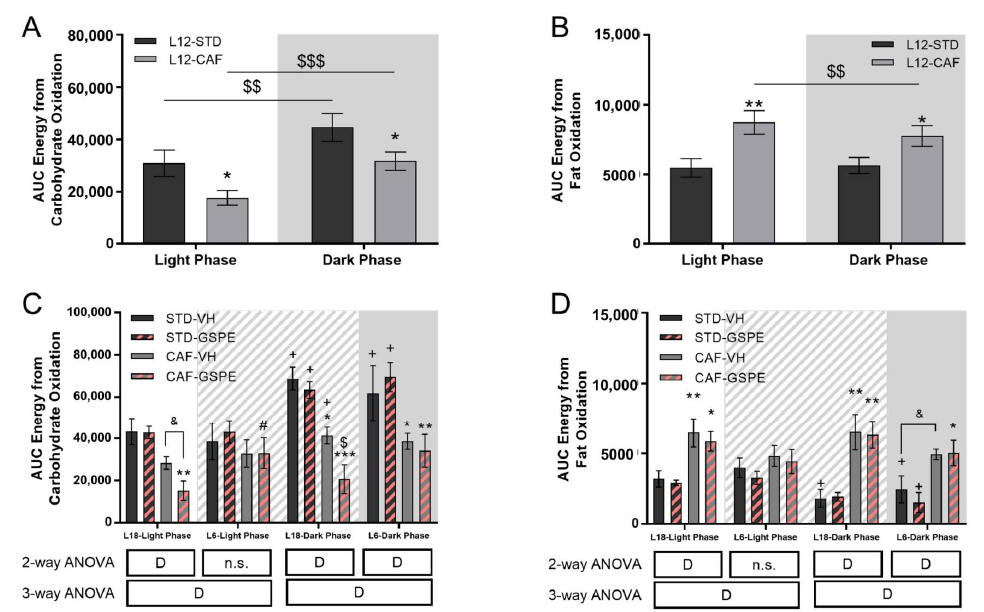
Figure 4. Energy from carbohydrate or fat oxidation of STD- and CAF-fed rats in the sixth week of the experiment under L12 conditions and in the seventh week of the experiment under L18 and L6 conditions. ( A ) AUC of energy from carbohydrate oxidation for STD- and CAF-fed rats under the L12 photoperiod. ( B ) AUC of energy from fat oxidation for STD-fed rats and VH or GSPE administration under the L18 photoperiod. ( C ) AUC of energy from carbohydrate oxidation for L6 and L18 conditions groups. ( D ) AUC of energy from fat oxidation for L6 and L18 conditions groups. For L12 conditions, values are expressed as the mean ± S.E.M. ( n = 24). ¥ or ¥¥ Indicate significant differences using an unpaired Student’s t -test between L12-STD vs. L12-CAF ( p ≤ 0.05 and p ≤ 0.01, respectively). Values are expressed as the mean ± S.E.M. ( n = 6). D, diet effect; n.s., no significant differences. *, ** or *** Indicate significant differences by diet effect ( p ≤ 0.05, p ≤ 0.01 and p ≤ 0.001, respectively), $, $$ or $$$ Indicate significant differences by treatment effect ( p ≤ 0.05, p ≤ 0.01 and p ≤ 0.001, respectively), # Indicates significant differences by photoperiod effect using 2-way and 3-way ANOVA followed by a LSD post-hoc test ( p ≤ 0.05). & Indicates tendency using a LSD post-hoc test ( p = 0.1–0.051). + Indicate significant differences using a paired Student´s t -test between Light Phase vs. Dark Phase for each group ( p ≤ 0.05, respectively). x Indicates tendency using a paired Student´s t- test between Light Phase vs. Dark Phase for each group ( p = 0.1–0.051). AUC, Area under curve; STD, Standard diet-fed rats; CAF, Cafeteria diet-fed rats; VH, rats administered vehicle; GSPE, rats administered 25 mg/kg grape seed proanthocyanidin-rich extract; L12, standard photoperiod 12 h light per day; L18, long photoperiod 18 h light per day; L6, short photoperiod 6 h light per day. Grey background, dark phase. slash background, transitions phase.